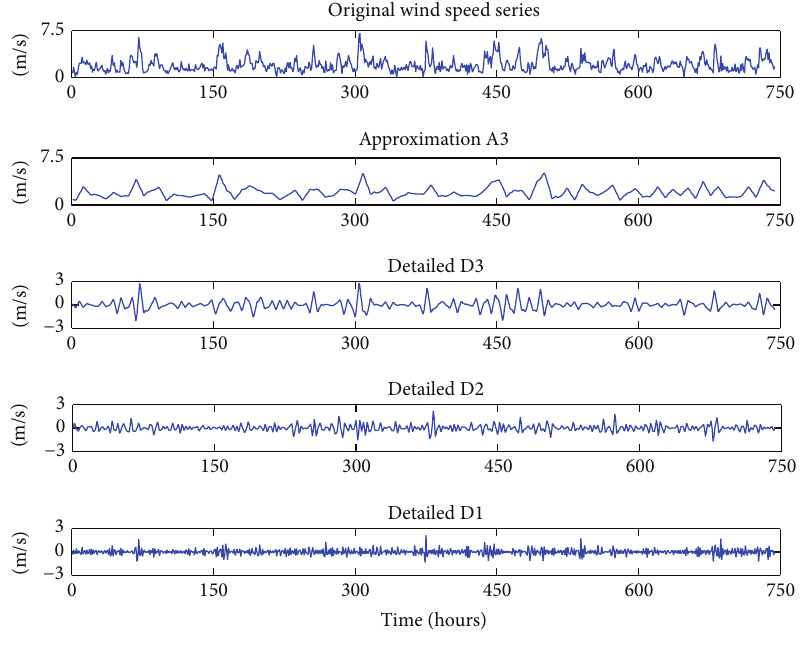
Figure 5: DWT results in spring.